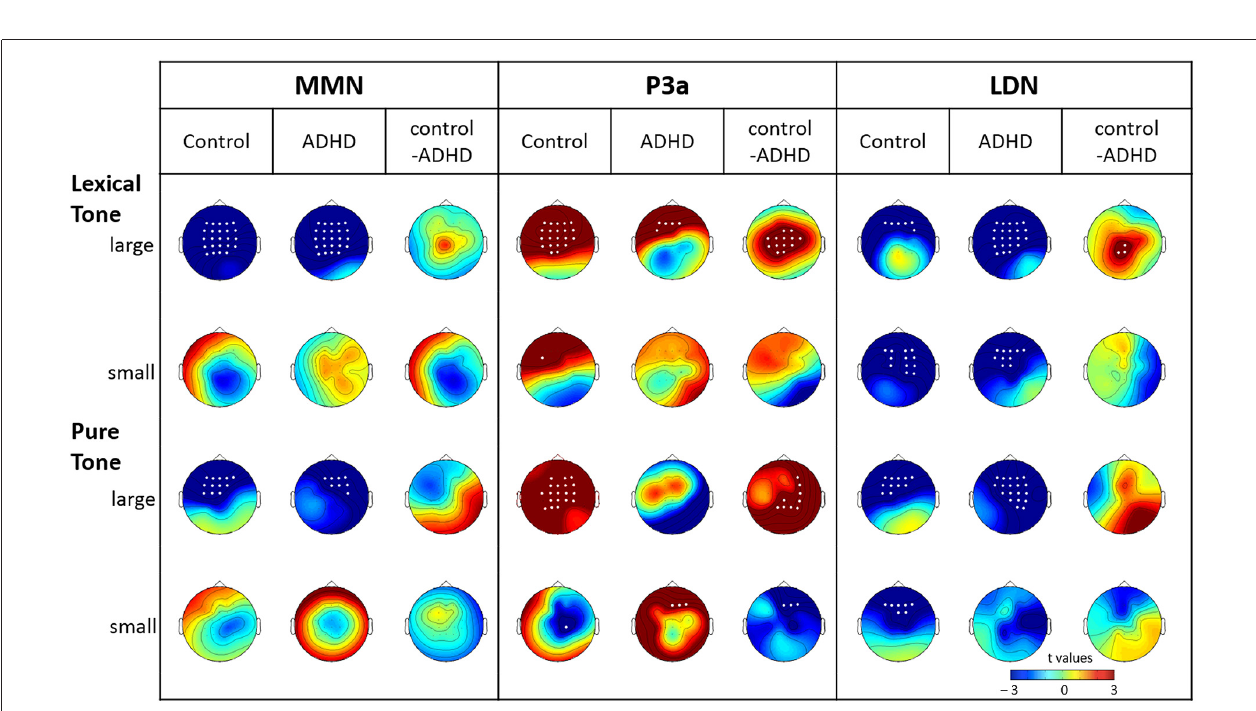
planned group comparison for each of them. White dots indicate electrodes with a significant difference between the standard and deviant or a significant group effect ( p <